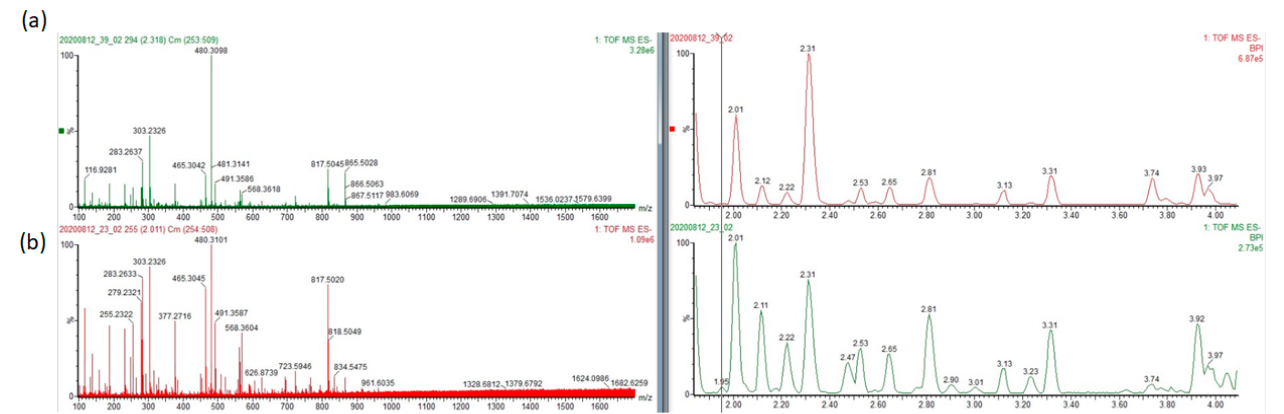
Figure 2. A representative figure of LC-MS between 2 and 4 min for a deceased male donor ( a ) and a living male donor ( b ). Table 2. The difference of lipidomics in MS-electrospray positive ion mode between deceased and living liver donors.